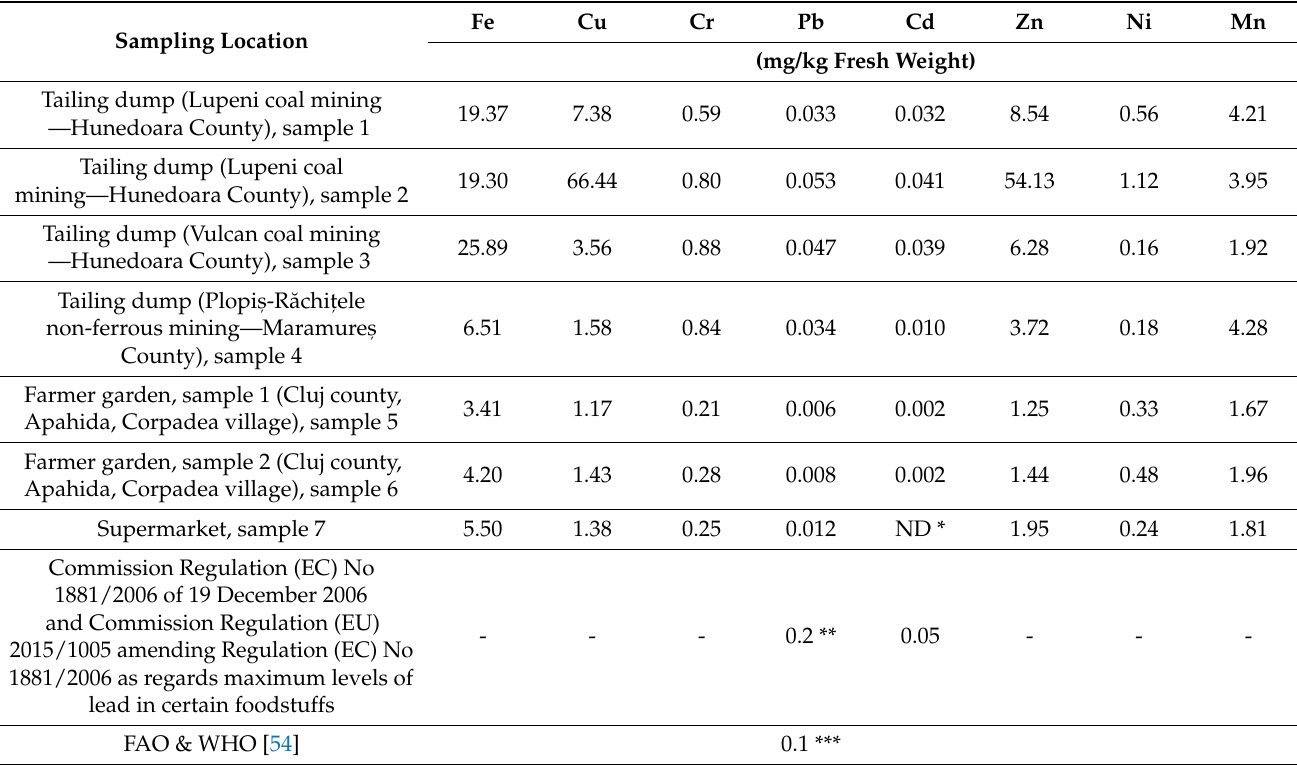
Table 3. Metal content (mg/kg fresh weight) in sea buckthorn